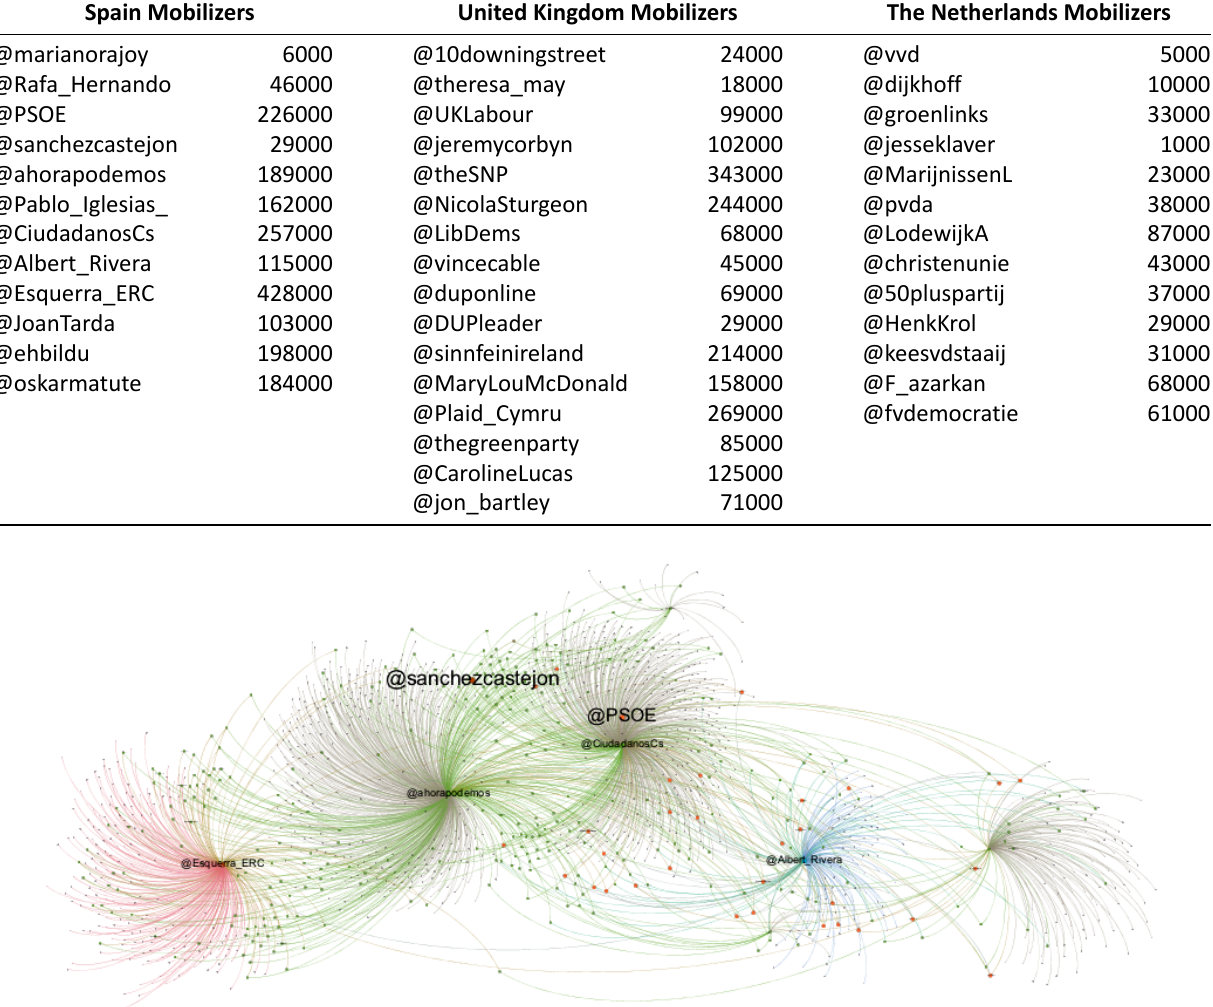
Table 5. Mobilizers, by country.